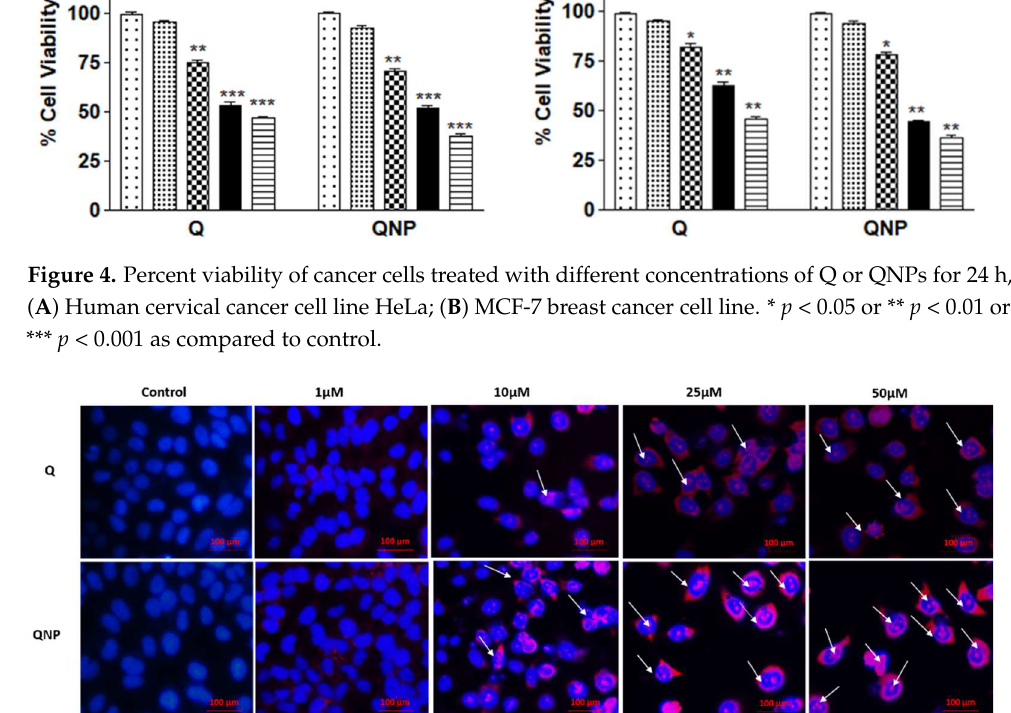
Figure 4. Percent viability of cancer cells treated with different concentrations of Q or QNPs for 24 h, ( A ) Human cervical cancer cell line HeLa; ( B ) MCF-7 breast cancer cell line. * p < 0.05 or ** p < 0.01 or *** p < 0.001 as compared to control.